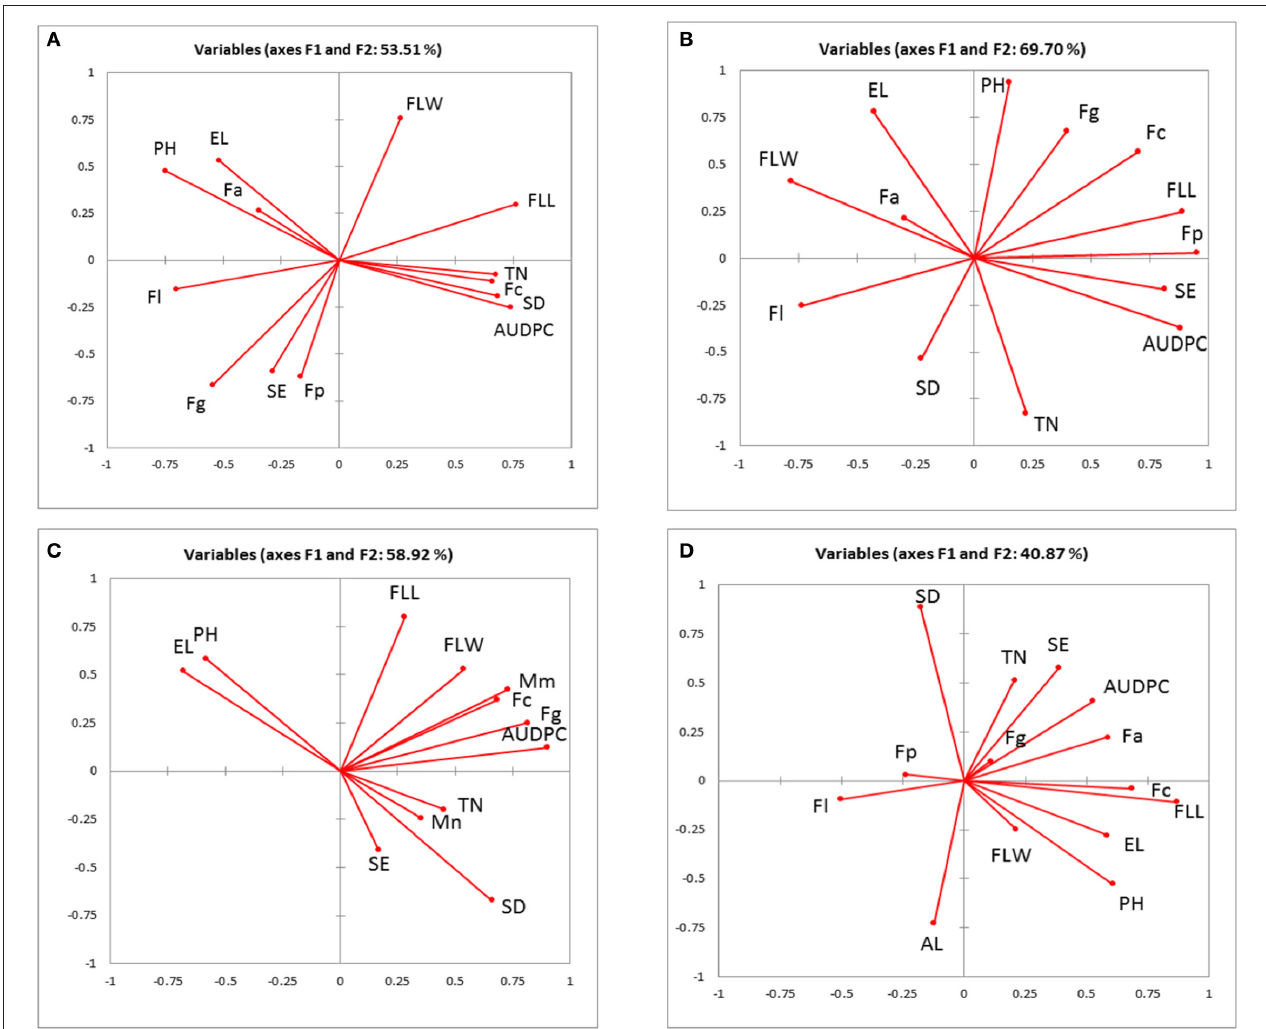
FIGURE 1 | Biplot of the principal component analysis of the Area under the disease progress curve (AUDPC), pathogen DNA (pg ng − 1 ), measured canopy and ear traits from (A) 2010 (B) 2011 (C) 2012 field experiment (D) 2011–2012 glasshouse experiments. EL, ear length; FLL, flag leaf length; FLW, flag leaf width; PH, plant height; SE, spikelets per ear; SD, spikelet density; TN, tiller number; AL, awns length; Fg, Fusarium graminearum ; Fc, F. culmorum ; Fp, F. poae; Fa, F. avenaceum ; F1, F. langsethiae ; Mm, Microdochium majus ; Mn, M. nivale